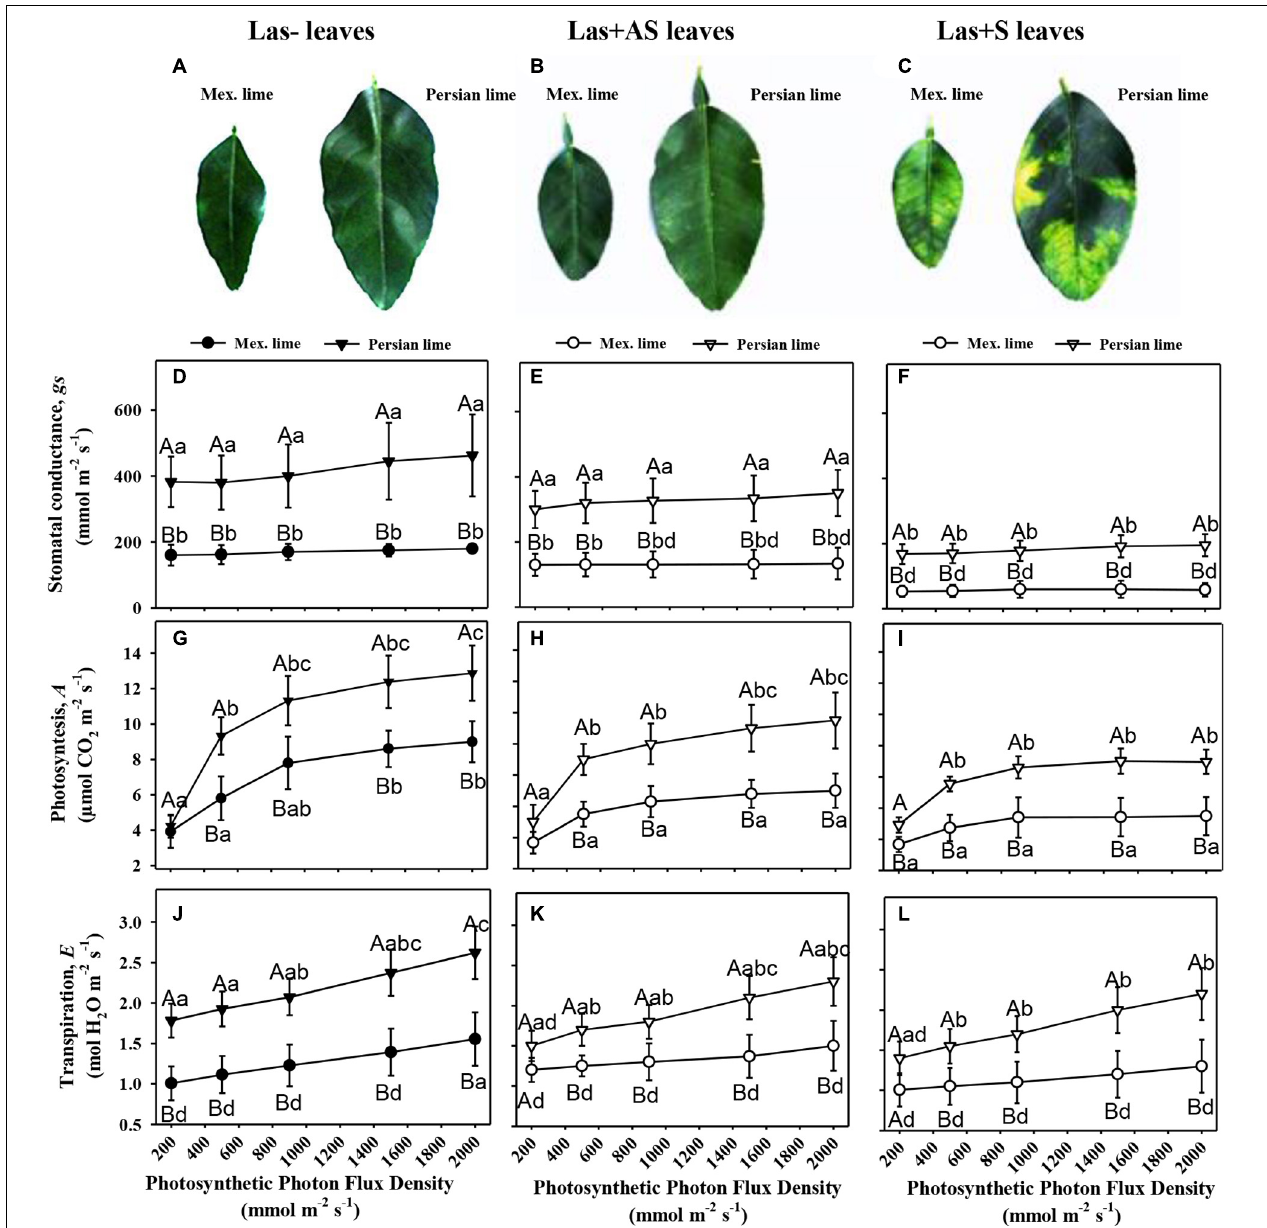
FIGURE 1 | Physiological impact of HLB in infected leaves that were asymptomatic (Las + AS) and symptomatic (Las + S) compared with control (Las − ) leaves from Mexican and Persian limes, respectively. Pictures of control (A) , Las + AS (B) , and Las + S (C) leaves of both cultivars. Stomatal conductance, gs (D–F) , photosynthesis, A (G–I) , and transpiration (J–L) measured in Las − , Las + AS, and Las + S leaves from Mexican and Persian limes, respectively, subjected to increased PPFD. The results are presented with mean values ± SE ( n = 10). For each given datum, different letters indicate a statistical difference